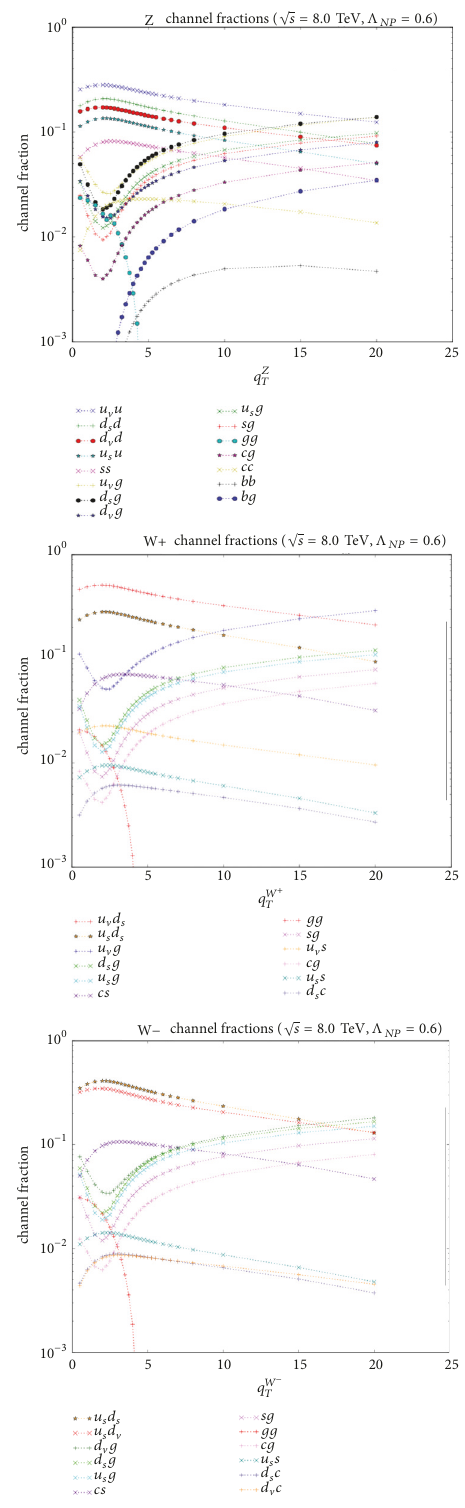
Figure 2: From top to bottom: the decomposition in flavour channels of the cross section 𝑑𝜎/𝑑𝑞 𝑇 for 𝑍 , 𝑊 + , 𝑊 − production differential with respect to the transverse momentum of the produced electroweak boson 𝑞 𝑉 𝑇 , 𝑉 = 𝑍,𝑊 + , 𝑊 − . The rapidity and the collinear momentum fractionshavebeen integratedoverthe kinematically allowed ranges. The cross sectionis calculatedby means of CuTe [12] atLHC √ 𝑠 = 8 TeV. The nonperturbative correction is implemented as a flavour-independent Gaussian smearing, governed by the parameter Λ 𝑁𝑃 (see [12] and the Appendix). The channels add to